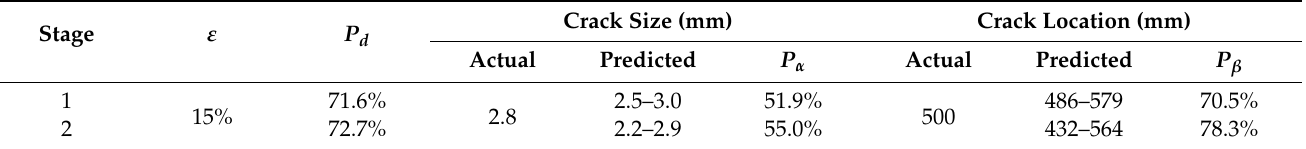
Table 5. Results summary for Case